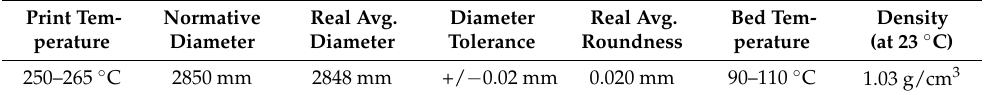
Table 1. Properties of ABS utilized in the study according to the production data sheet [19]. Print Tem- Normative perature